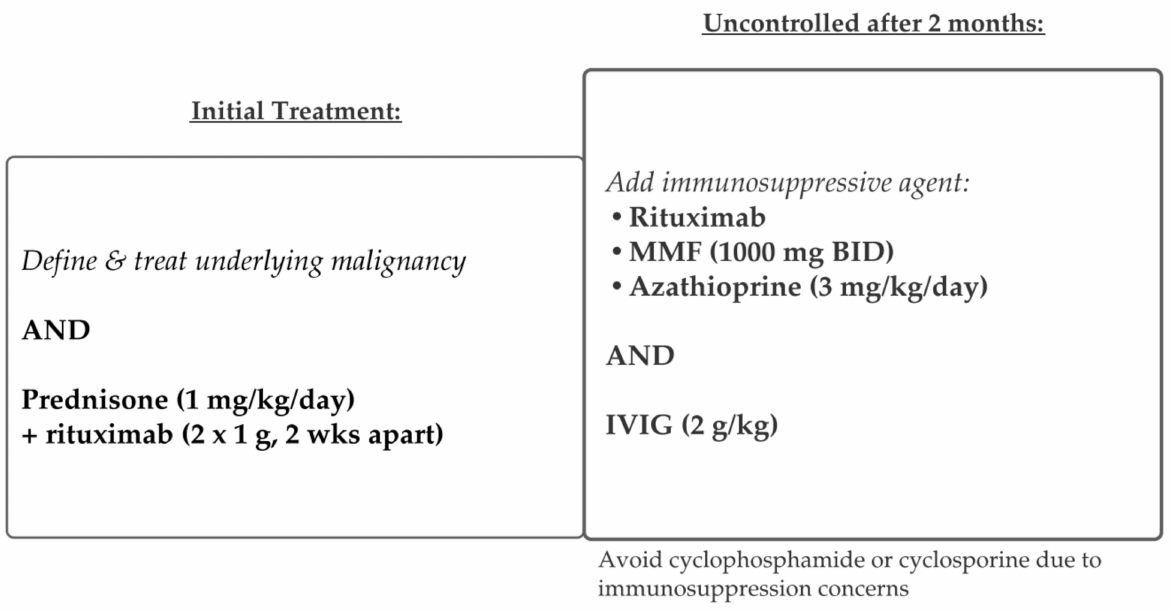
Figure 8. Treatment schema for paraneoplastic